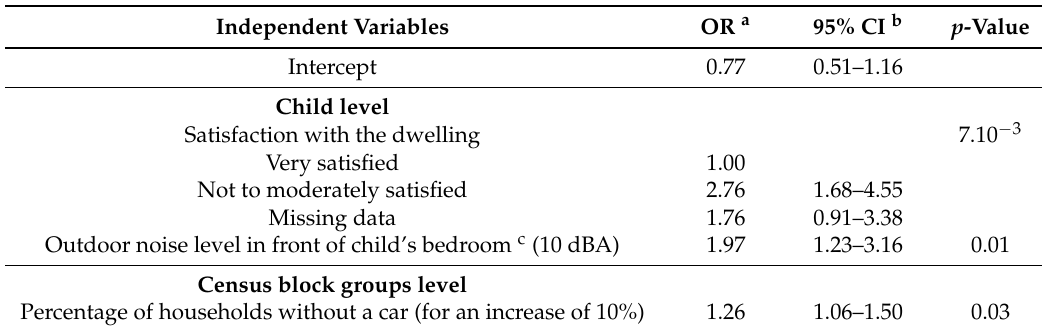
Table 6. Annoyance caused by ambient noise in children: multivariate